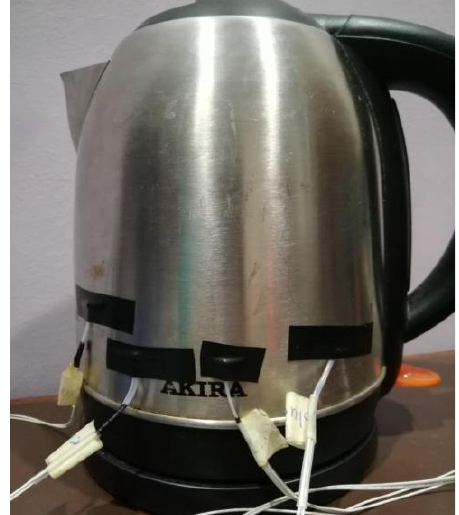
Figure 2. Attaching thermal sensors on an electric kettle